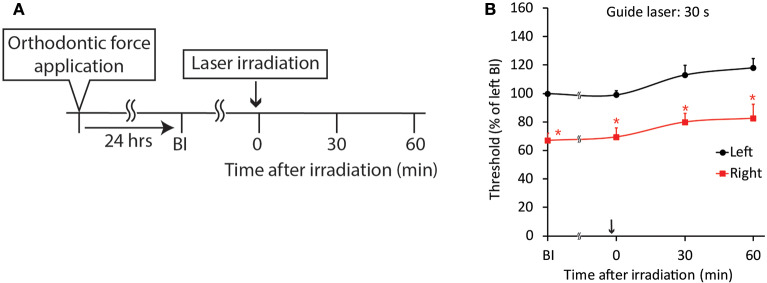
Effect of guide laser irradiation on orthodontic treatment-induced excitation of the jaw-opening reflex. (A) Experimental procedure for the application of orthodontic force, guide laser irradiation and the evaluation of jaw-opening reflex excitability. (B) One day of orthodontic force application significantly reduced the right-side threshold for inducing the jaw-opening reflex, and guide laser irradiation of the maxillary first molar region for 30 s failed to alter the reduction in the threshold for 60 min. BI: before laser irradiation. Arrow: laser irradiation. Left vs. right: two-way ANOVA, side: p < 0.05, time: p < 0.05, side × time: p < 0.05; Bonferroni post hoc test, *p < 0.05 vs. “BI of left”.